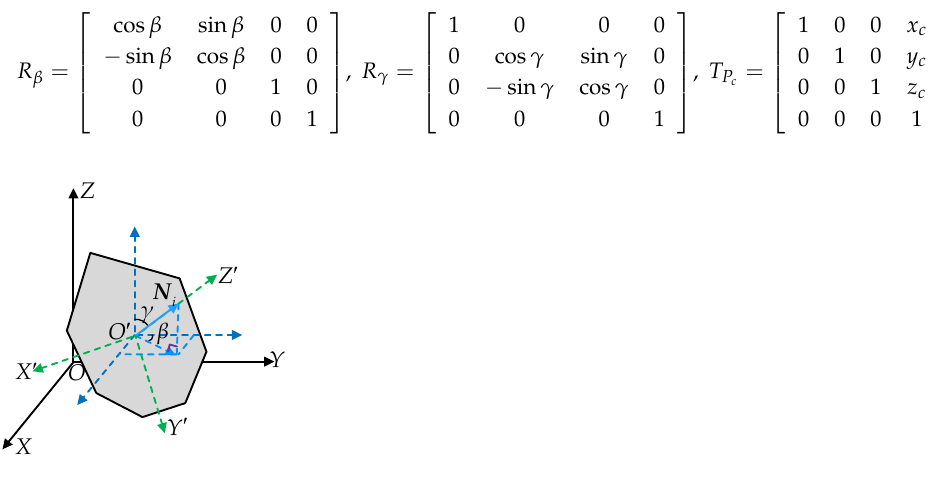
Figure 4. Coordinate description.